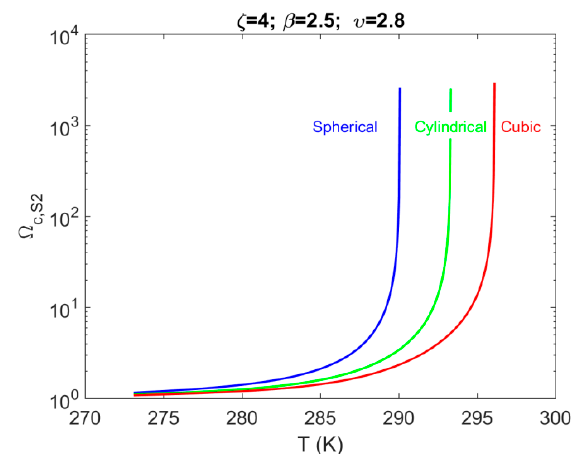
−Ω 1 −Ω 1 1 , Sc as a function of temperature along the three-phase (H–L w – 1 , Sc